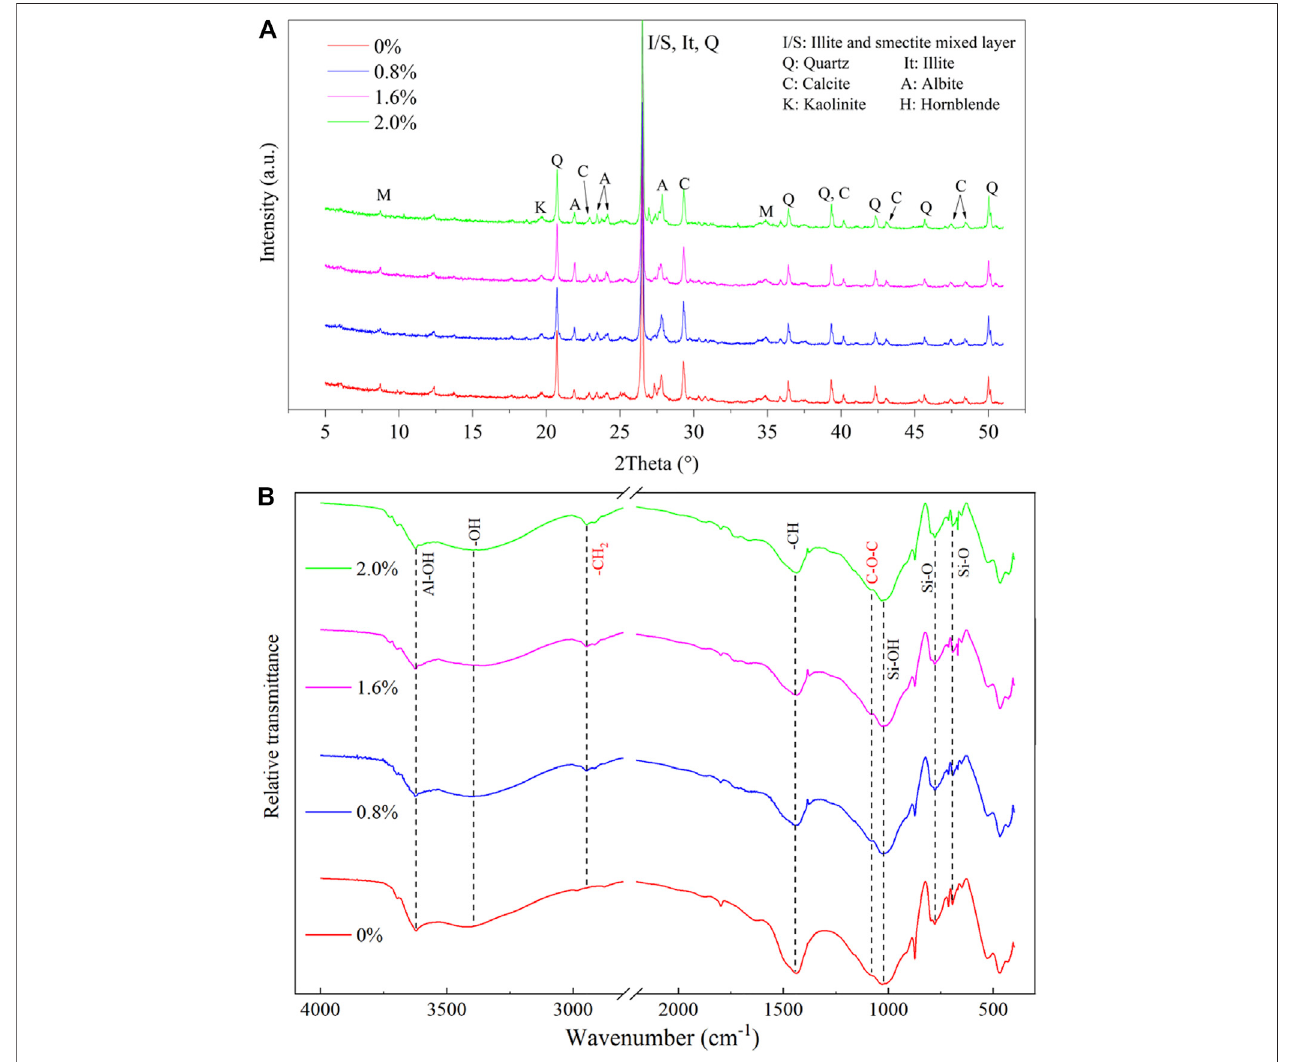
FIGURE11|(A) X-raydiffraction patternsofloesstreatedwithdifferentcross-linkedpolymerconcentrations. (B) Fourier-transforminfraredre fl ectionspectrogram of loess treated with different cross-linked polymer concentrations.